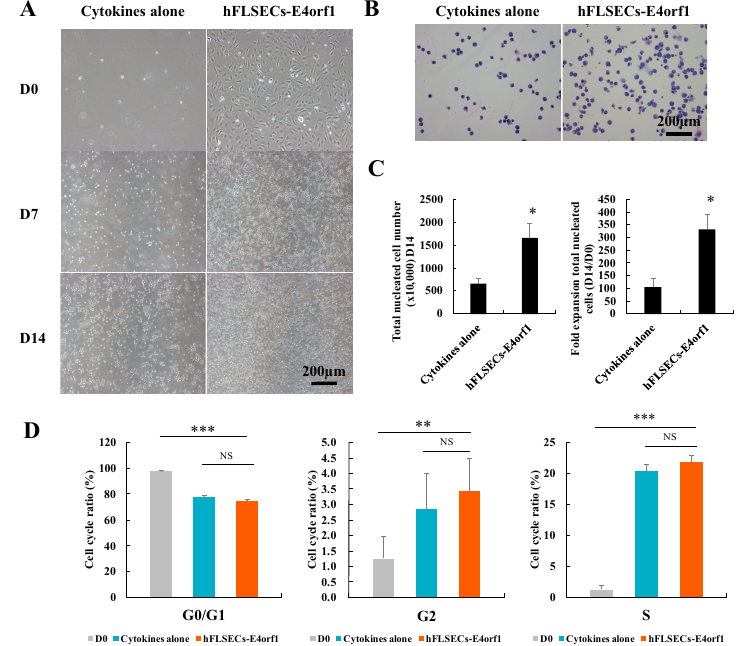
Figure 2. Culture of CD34 + hCB cells with hFLSECs-E4orf1 resulted in expansion of TNCs while retaining the HSC pool size. ( A ) Morphology of CD34 + hCB cells expanded on day 0, day 7, and day 14 under cytokines culture alone or with hFLSECs-E4orf1 coculture. Cocultured CD34 + hCB cells suspended over the adherent hFLSECs-E4orf1. ( B ) Giemsa-staining for cytospin samples of amplified CD34 + hCB cells on day 14. ( C ). TNC expansion. ( D ) Cell cycle analysis. Freshly isolated CD34 + hCB cells serve as a control. Scale bars: 200 µ m. Data represented as mean ± SEM. NS means “no significant difference”. n = 6. * p < 0.05, ** p < 0.01, *** p < 0.001.